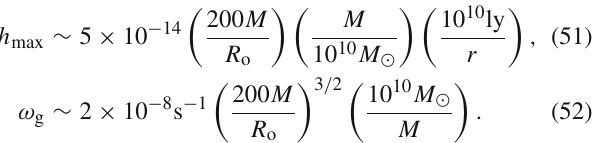
with the maximum strain amplitude and the GW